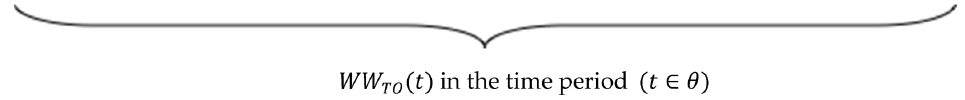
∑ 4 c 3 j q i —Is the expected value of the loss of the (OP) sub-system in the (GS) if the (TO) j = 1 TO ∑ 4 c 4 j q i —Is the expected value of the loss of the (OP) sub-system in the (GS) if the j = 1 TO